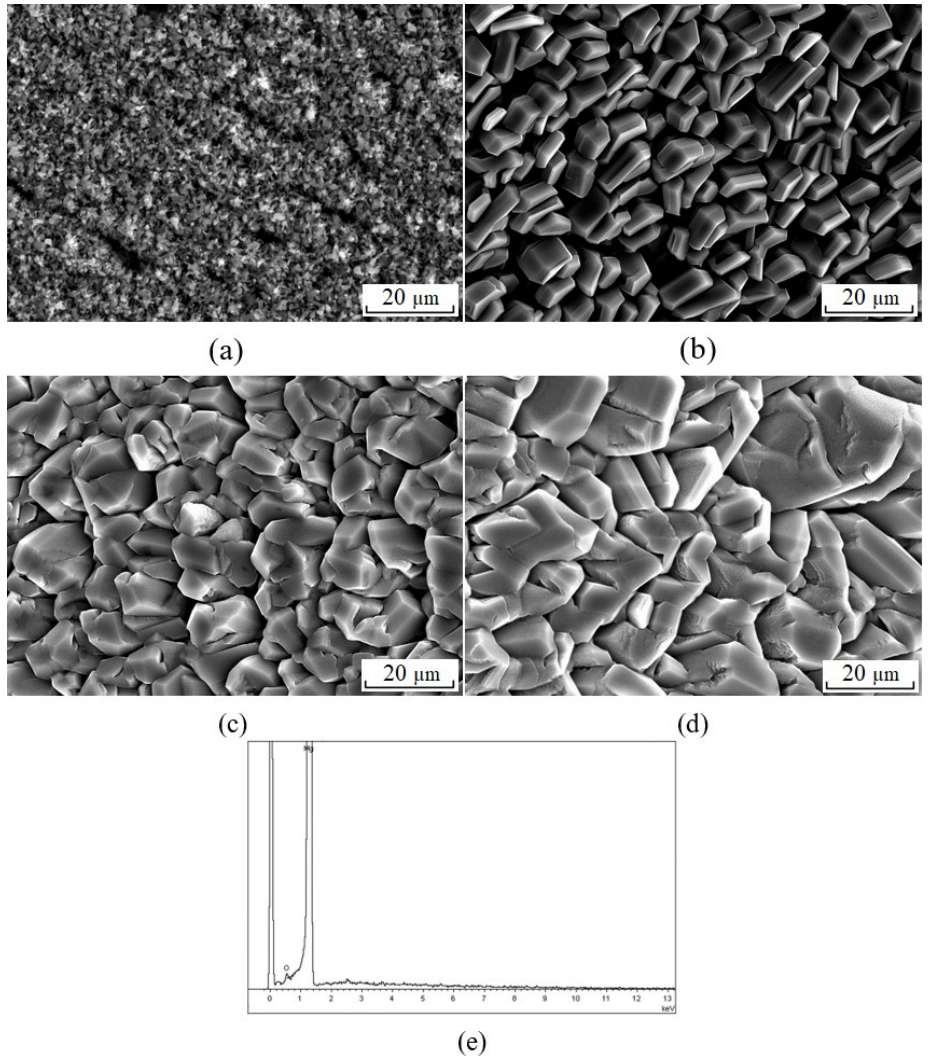
Figure 2. Surface morphologies of Mg coating at different substrate temperatures: ( a ) 150 °C, ( b ) 170 °C, ( c ) 190 °C, and ( d ) 210 °C; and ( e ) EDS analysis.